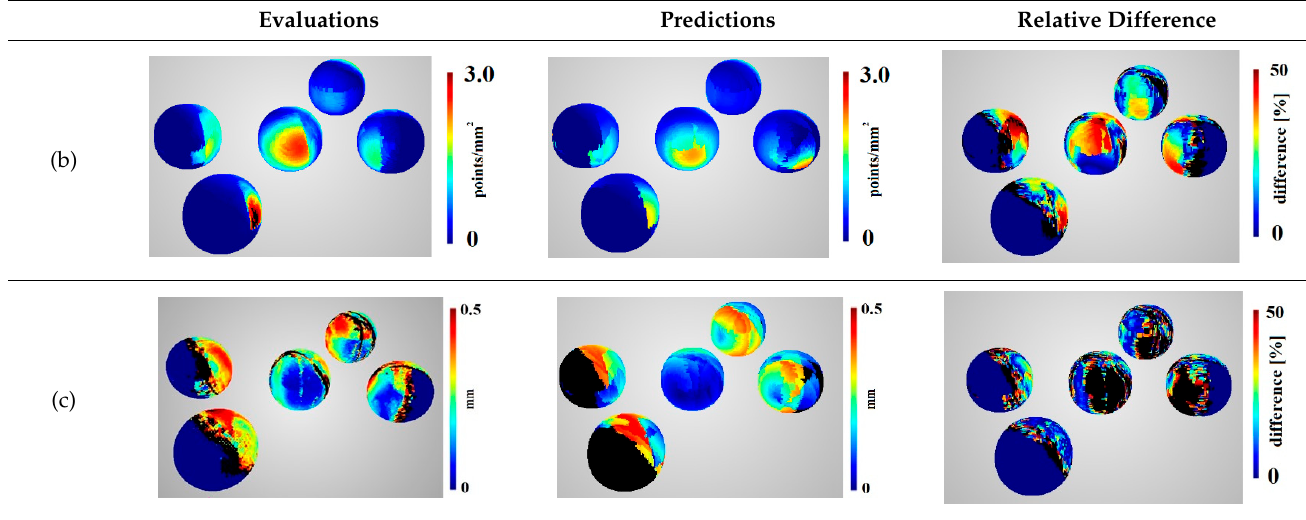
Table A2. Comparison of predictions and evaluations of a quasi-optimal 360-degree scene from Figure 17: (a) reconstruction’s coverage (red points represent covered areas for evaluations and predictions, and for relative difference, invalid predictions), (b) density, and (c) accuracy.